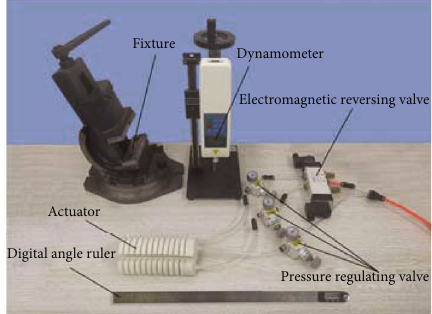
Figure 10: Experimental test